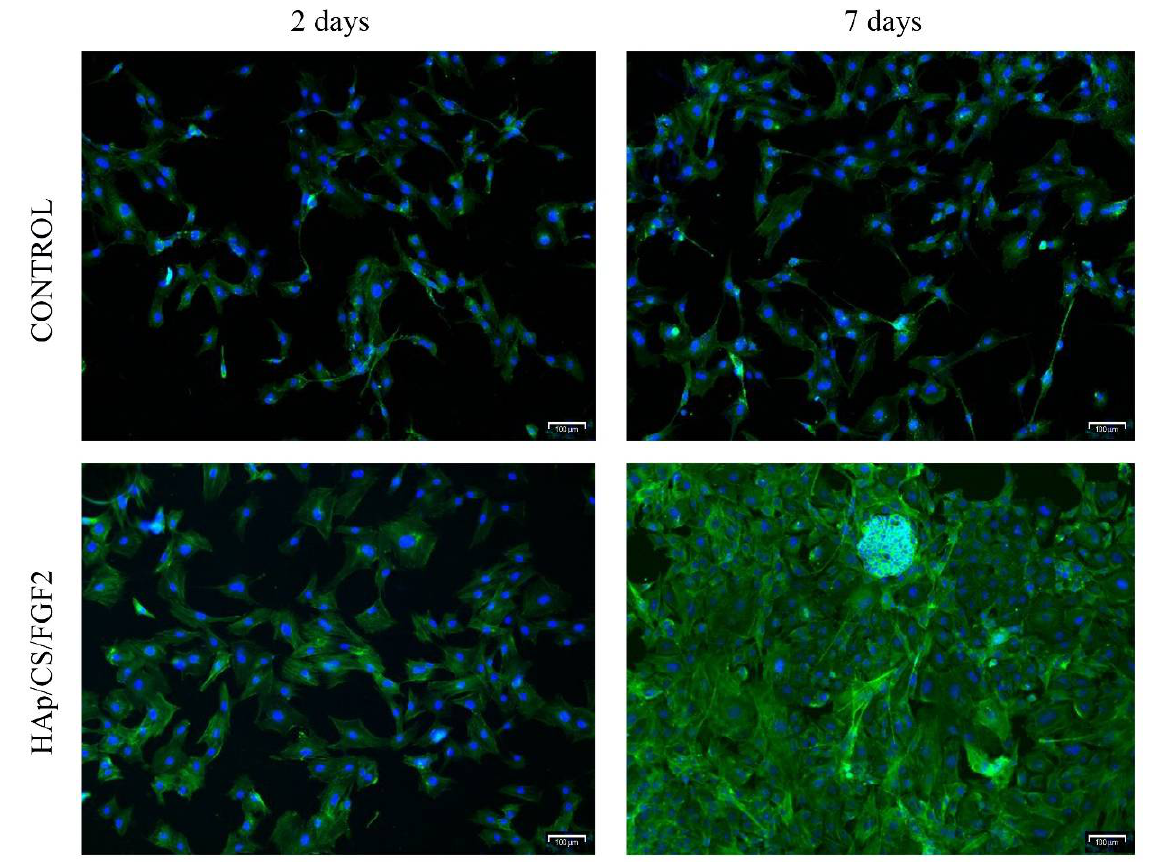
Figure 7. Fluorescence microscopy micrographs (scale bar 100 μm) highlighting the cytoskeleton of MC3T3-E1 cells 2 days and 7 days post-seeding on control and Hap/CS/FGF2 samples. Actin filaments were stained with phalloidin-FITC (green) and cell nuclei with DAPI (blue).